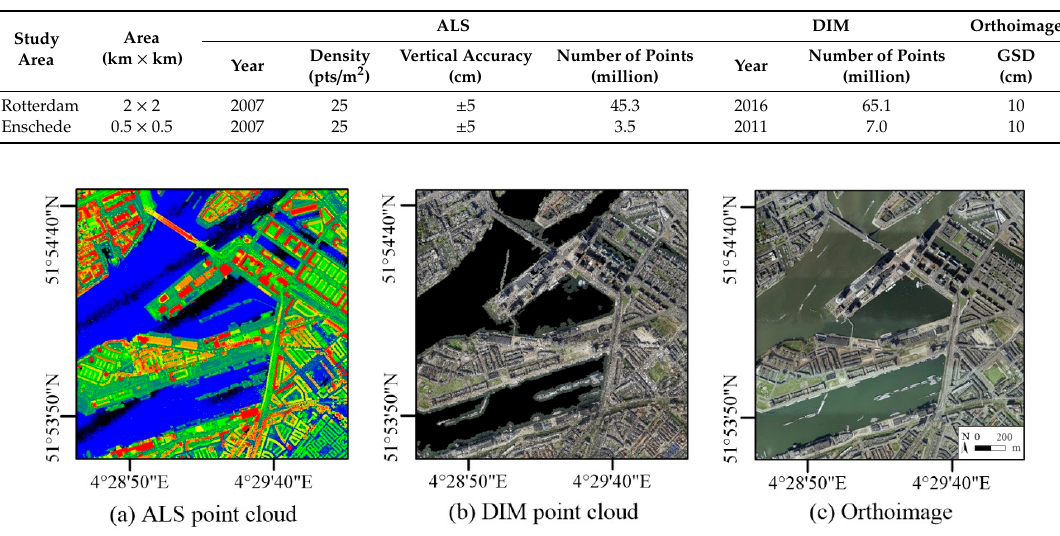
Figure 5. Visualization of the Rotterdam study area. ALS point cloud is colored according to height. DIM point cloud is colored with true color.